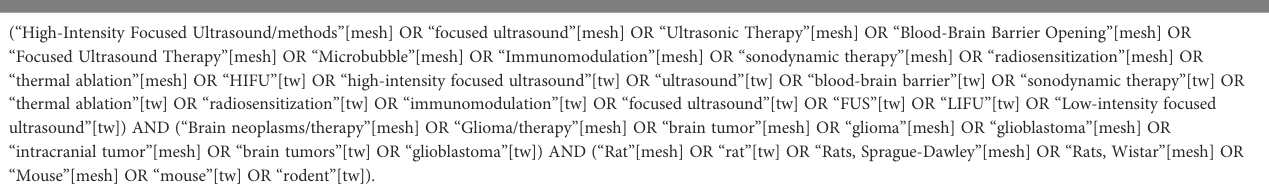
TABLE 1 Example of search algorithm created for PubMed. [mesh] refer to mesh terms and [tw] refer to keywords. PubMed: 1,555 search results